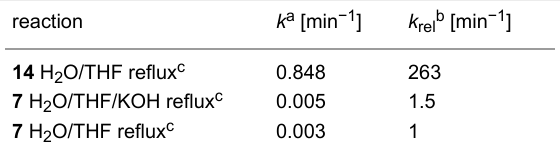
Table 2: Hydrolyses of dichlorosilanes 7 and 14 to the corresponding silanediols 9 and 15 (Figure 3, Scheme 3 and Scheme 4, absolute reaction constant k and relative reaction constant k rel